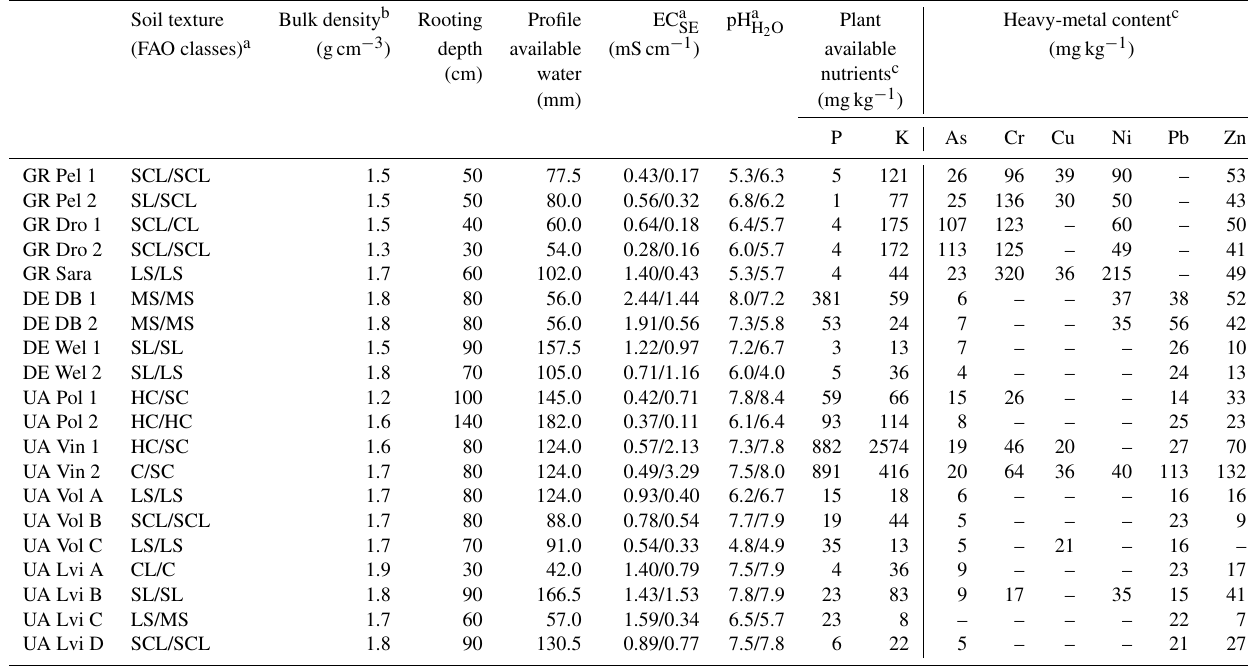
Table A1. Properties of investigated soil profiles at the investigated case study